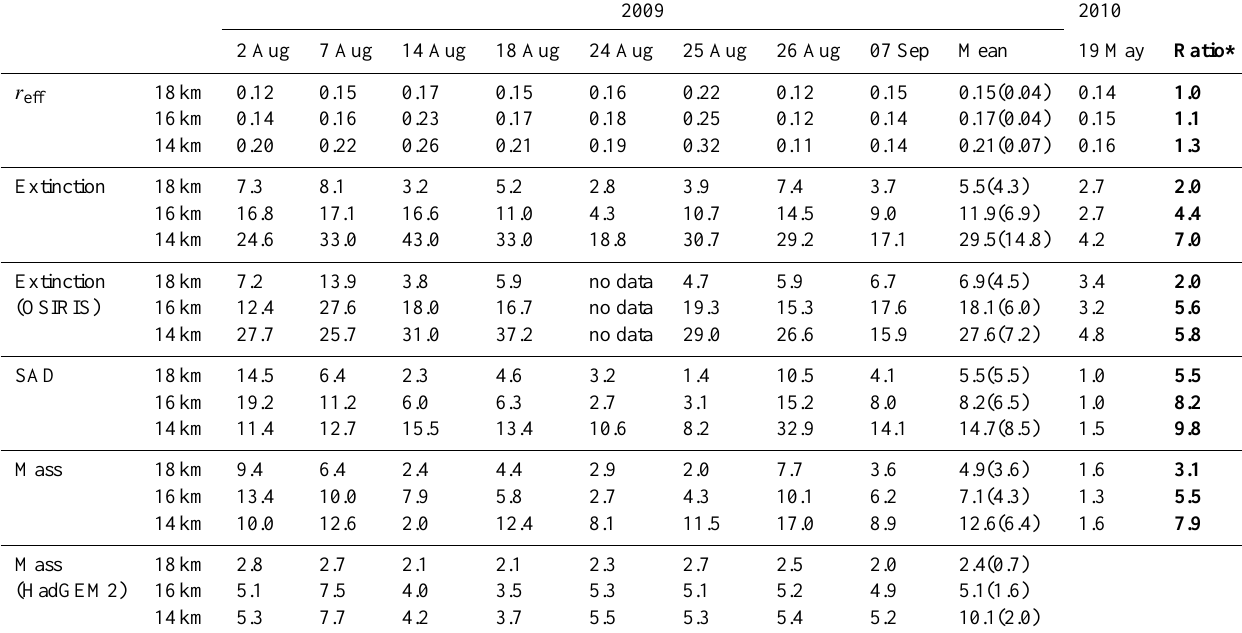
Table 1. STAC average values at 14, 16, and 18km ( ± 1km) of effective radius (µm), aerosol coefficient extinction at 740nm (10 − 4 km − 1 ), between the summer 2009 mean value (StraPol´ET´e campaign) and the 19 May 2010 background value (AEROWAVE campaign).